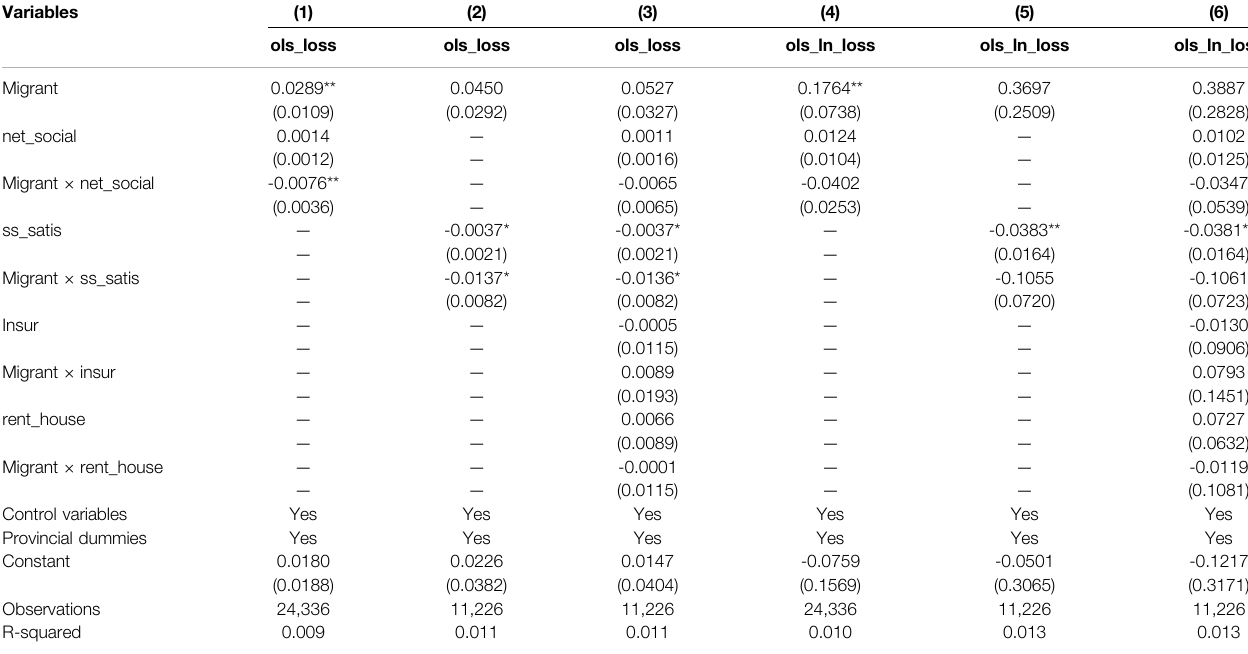
TABLE 8 | The impact channel analysis of risk of households being defrauded on migrant.